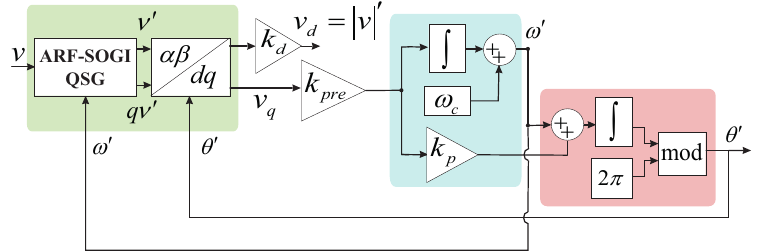
Figure 11. Structure of the ARF-SOGI-PLL.